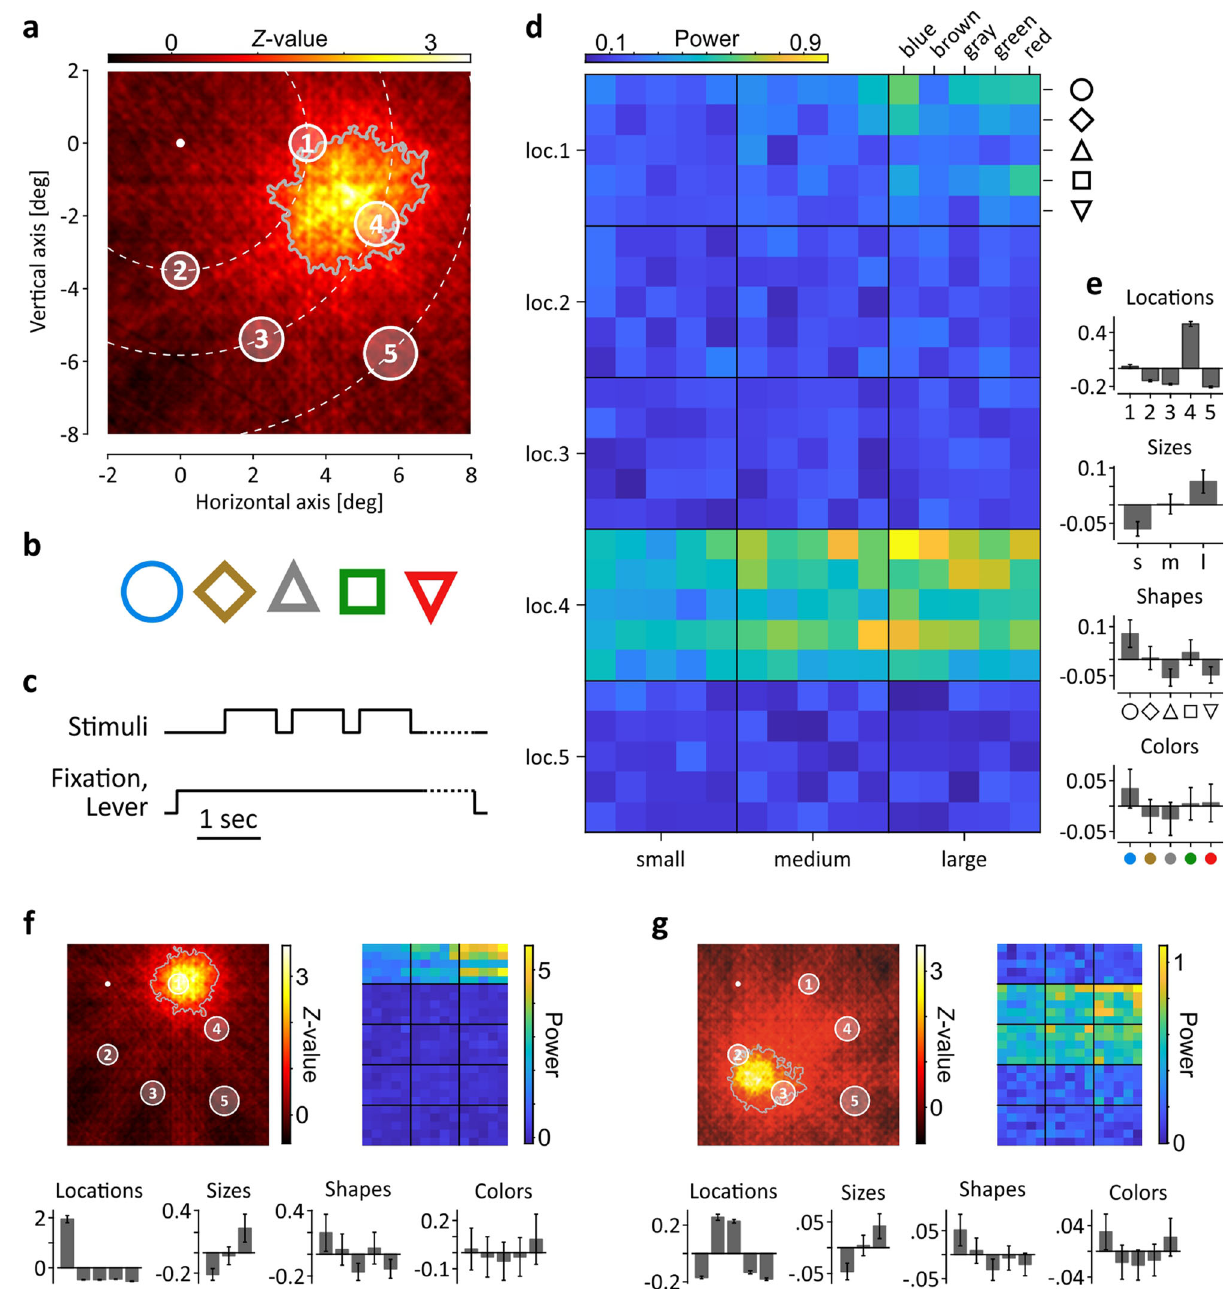
Fig. 1 Visual stimulation, experimental paradigm, and broadband-gamma [25 – 160 Hz] responses at three example channels. a Response map illustrating ERF (area de fi ned by gray line) and stimulus locations (open circles) in visual fi eld coordinates. Increasing circle diameter from inner to outer locations represent the three different stimulus sizes. White dot indicates fi xation point, dashed lines indicate iso-eccentricity at 3.5, 5.8, and 8.2 visual degree (deg). b Stimulus shapes and colors. Shape outlines were matched in thickness to provide identical number of pixels across shapes. Color isoluminance was matched by photometry. Each shape was shown at each location, in each color and size, providing a total of 375 stimulus conditions. c Time course of visual stimulation and behavioral paradigm. Dashed segment toward end of trial indicates randomized period of up to 1.1 s before the to-be- detected event (dimming of fi xation point). d Response matrix indicating trial-averaged broadband-gamma power for each of the 375 stimulus conditions. e Barplots summarizing gamma-band responses ( y -axis) per category and condition, as obtained from the individual conditions shown in ( d ). For better visualization, mean power overall conditions was subtracted from each individual condition. Labelling of x -axis for sizes corresponds to small (s), medium (m), and large (l). f – g ERF maps, response matrixes, and barplots for condition-speci fi c differences in mean gamma power per category of two more example channels ( f M2; g M1). X -axes of histograms correspond to ( d ). Error lines in barplots indicate SEM throughout.